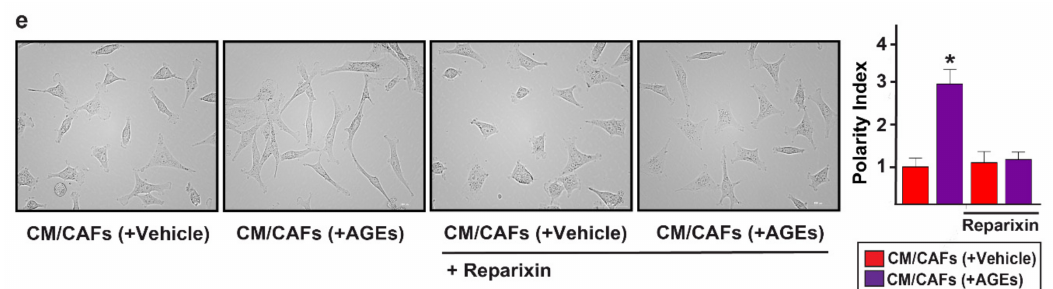
Figure 4. IL-8 mediates the acquisition of a spindle-like morphology in MDA-MB-231 cells triggered by conditioned medium (CM) from AGEs-stimulated CAFs. ( a ) CXCR1/2 mRNA levels according to breast cancer intrinsic molecular subtypes of the integrated Affymetrix cohort; ( b ) CXCR1/2 expression is associated with a worse relapse-free survival (RFS) of basal breast cancer patients in the Affymetrix dataset. The patients were divided into high and low CXCR1/2 expression levels on the basis of the established cut-point’ ( c ) MDA-MB-231 cells were incubated for 6 h with CM collected from CAFs previously treated with vehicle or 100 µ g/mL AGEs in the presence or absence of 1 µ M RAGE inhibitor FPS-ZM1’ ( d ) MDA-MB-231 cells were cultured for 6 h in CM derived from CAFs previously treated with vehicle or 100 µ g/mL AGEs with or without 300 ng/mL IL-8 neutralizing-antibody (Ab IL-8) as well as ( e ) using 5 µ M CXCR1/2 inhibitor reparixin. The spindle- like morphology was quantified as Polarity Index (PI). PI = 1.0 indicates a polygonal shape, conversely a value > 1.0 identified ranges of migratory shapes. Images shown are representative of 10 random fields acquired in three independent experiments. Scale bar = 100 µ m. (*) indicates p < 0.05.